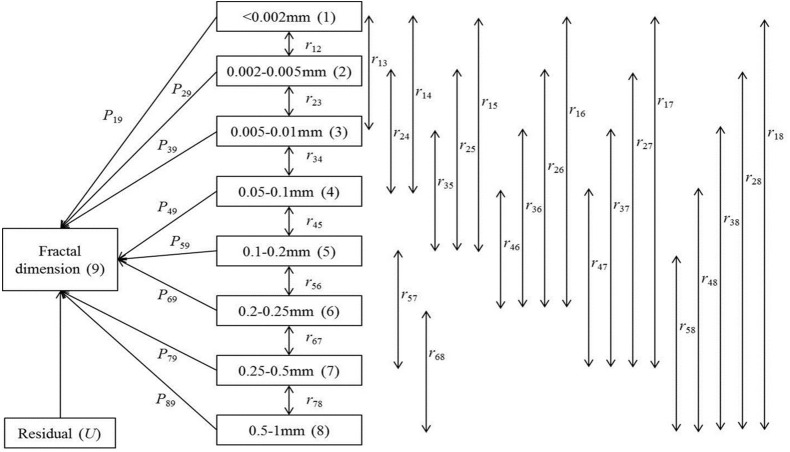
Path analysis diagram for the relationships between fractal dimension and micro-aggregate fractions.Note: Direct path coefficients (Pij) of micro-aggregate fractions are presented by single-headed arrows while simple correlation coefficients (rij) between variables are represented by double-headed arrows. Subscript designations of 1–9 are <0.002, 0.002–0.005, 0.005–0.01, 0.05–0.1, 0.1–0.2, 0.2–0.25, 0.25–0.5, 0.5–1 mm micro-aggregates, and fractal dimension (Dv), respectively.